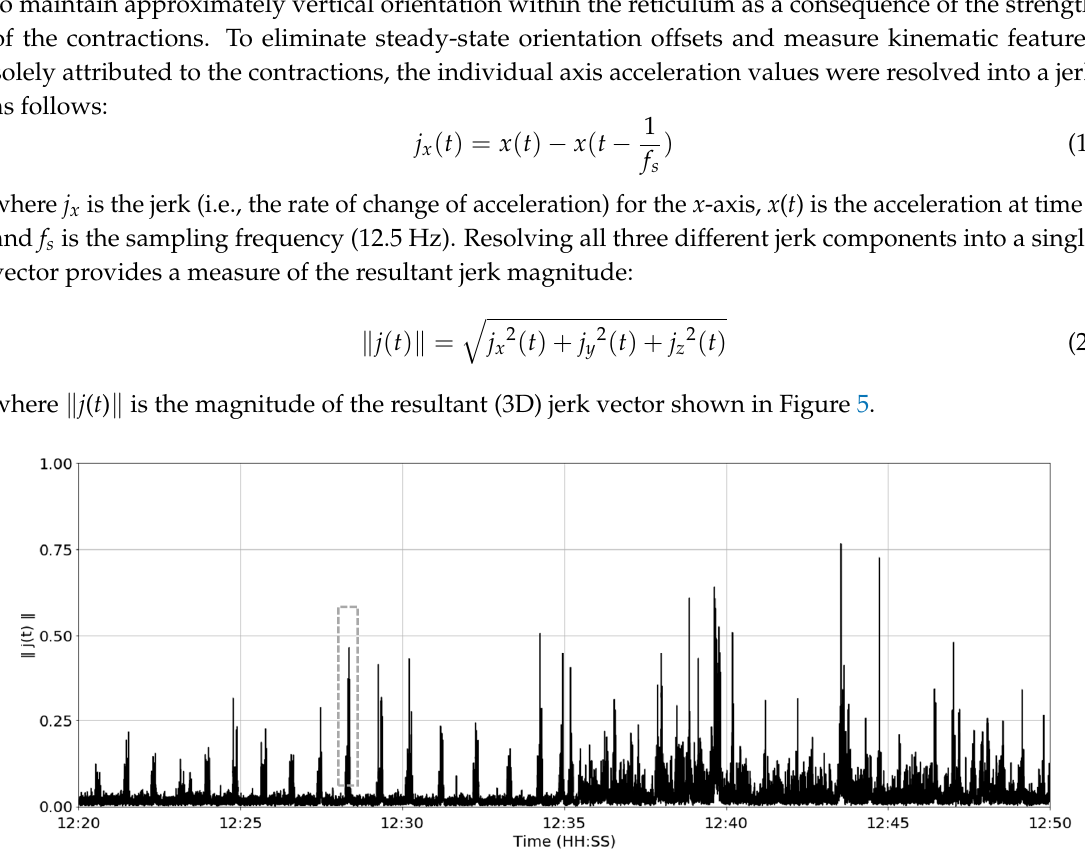
Figure 5. The magnitude of the resultant jerk vector over time for cow #2. Single peak during the apparent rumination period is illustrated with the grey dashed line.